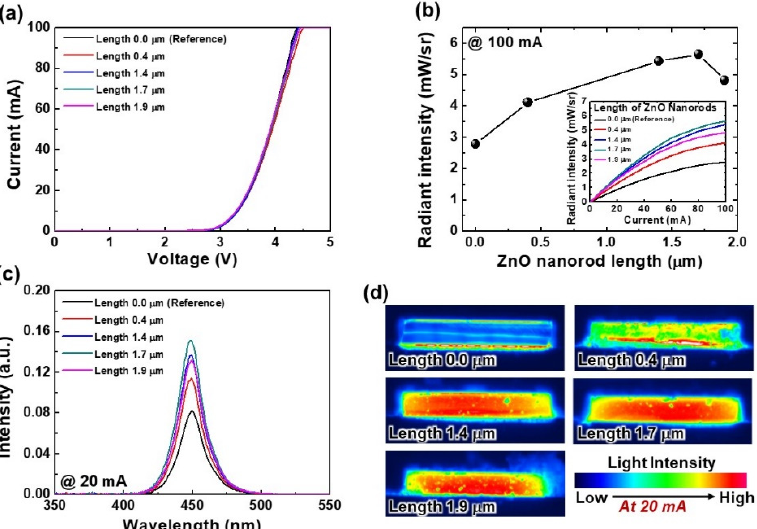
Figure 4. ( a ) I-V characteristics of reference and various lengths of ZnO nanorods USE-LEDs. ( b ) Change in peak amplitude of LOP with the variation of ZnO nanorods length at 100 mA. Inset shows the current vs. LOP characteristics of LED devices. ( c ) EL spectra, and ( d ) EL intensity distribution over the sidewall area at 20 mA for without and with various lengths of ZnO nanorods USE-LEDs.